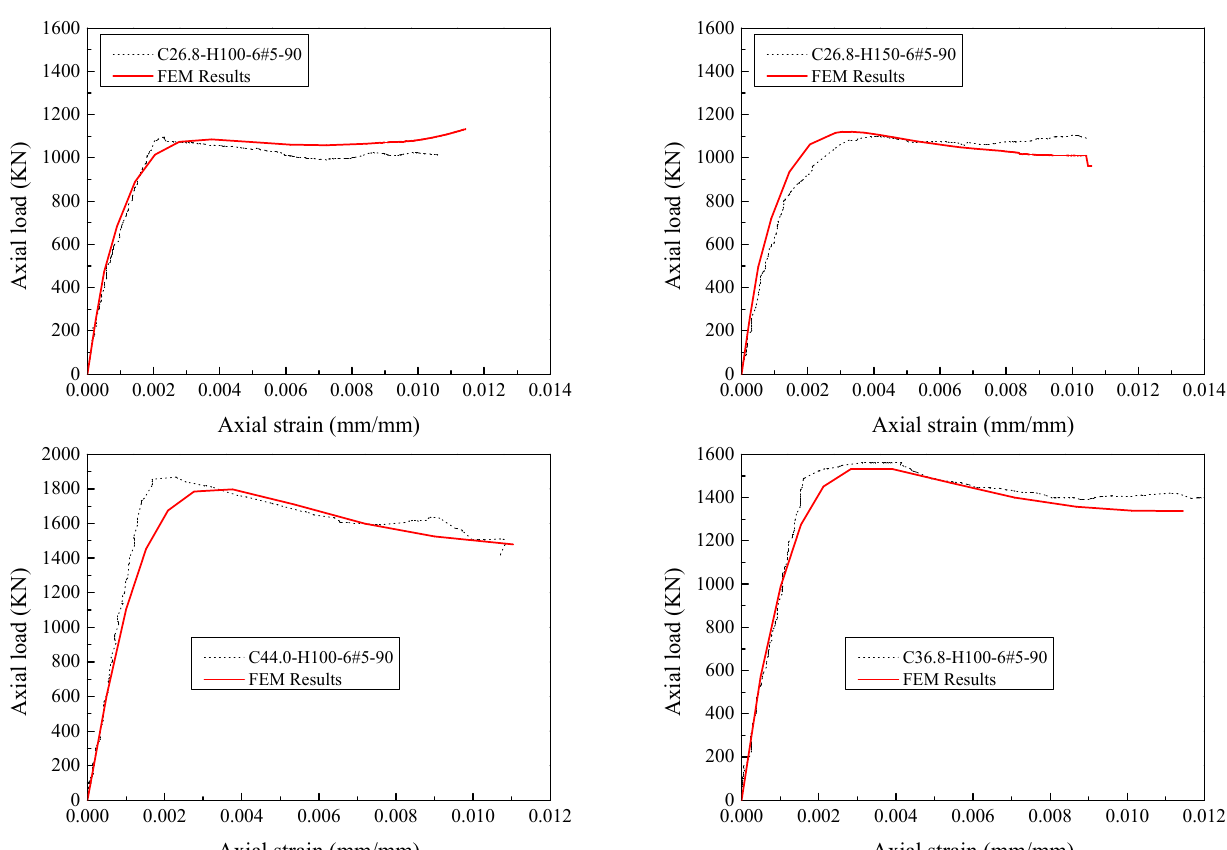
Figure 13. Comparison of tested and numerically obtained load-strain responses of HCCs.